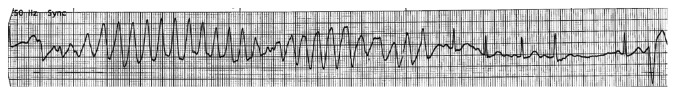
Rhythm strips with episodes of torsade des pointes terminating spontaneously.